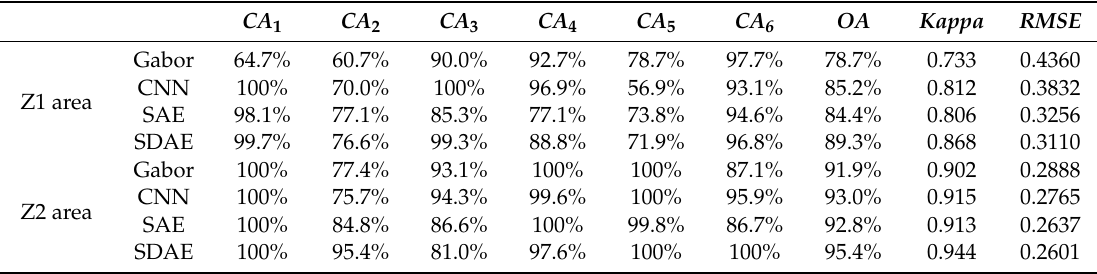
Table 3. Testing set evaluation indexes of feature extraction methods in the Z1 and Z2